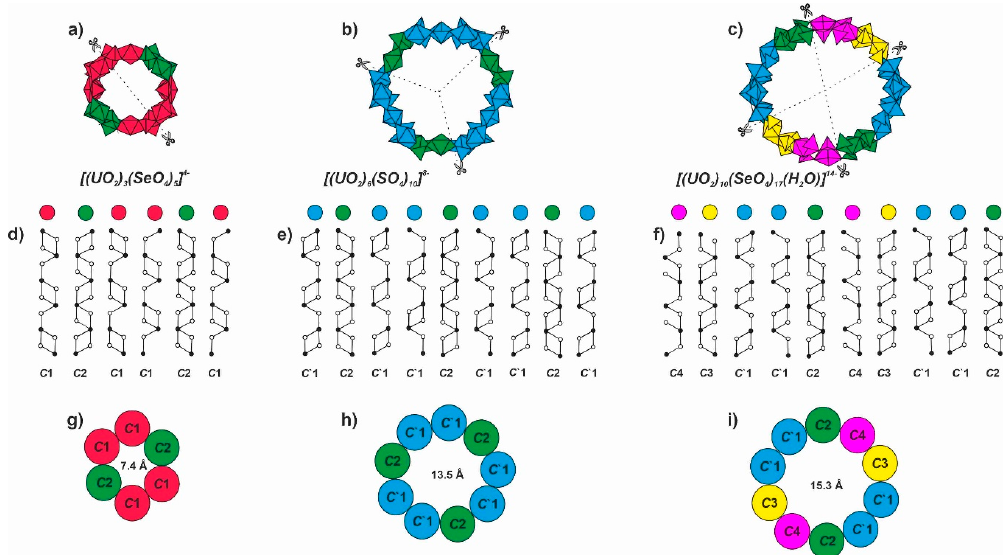
Figure 6. ( a ) Known uranyl-based nanotubules in K 5 (UO 2 ) 3 (SeO 4 ) 5 (NO 3 ) ∙ 3.5(H 2 O), ( b ) Na(C 8 H 10 NO 2 ) 7 [(UO 2 ) 6 (SO 4 ) 10 ] ∙ 3.5H 2 O, ( c ) (C 4 H 12 N) 14 [(UO 2 ) 10 (SeO 4 ) 17 (H 2 O)]. ( d – f ) Nanotubules are cut into equal parts. The color indicates the chain type used in the construction of the NT. ( g – i ) Schematic representation of the tube. The inner diameters are defined as the distances between the opposite closest oxygen